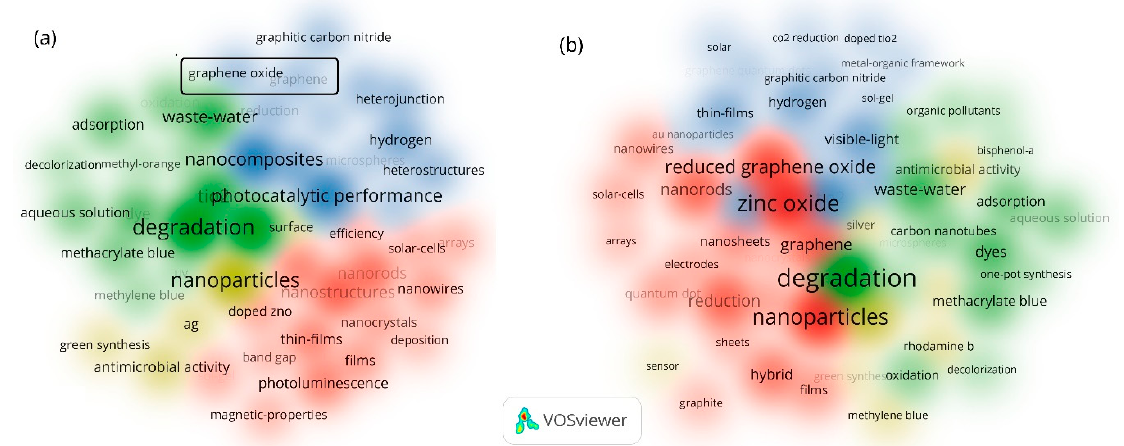
Figure 7. Keyword co-occurrence map for ( a ) ZnO photocatal* search (time span: 2016–2020, frequency count >150); ( b ) ZnO photocatal* graphene search (time span: 2016–2020, frequency count >7). Source: Web of knowledge, 24 September 2020.